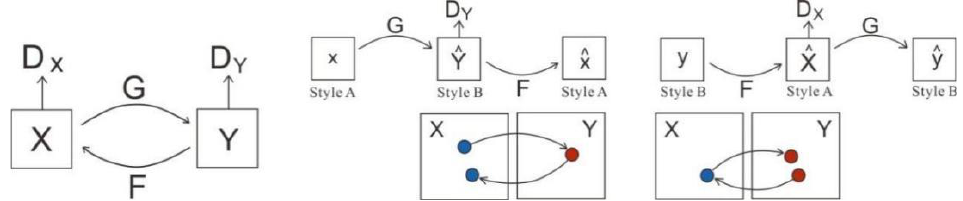
Figure 1. Structure diagram of cyclic consistency generative adversarial network [27]. Model contains the two mapping functions G: X → Y and F: Y → X , and the associated adversarial discriminators D Y and D X . D Y encourages G to translate X into outputs indistinguishable from the domain Y , and vice versa for D X and F . We introduced two cycle-consistency losses that illustrated the idea of translating from one domain to the other and back. We should arrive at where we started: forward cycle-consistency loss: x → G(x) → F(G(x)) ≈ x , and backward cycle-consistency loss: y → F(y) → G(F(y)) ≈ y .